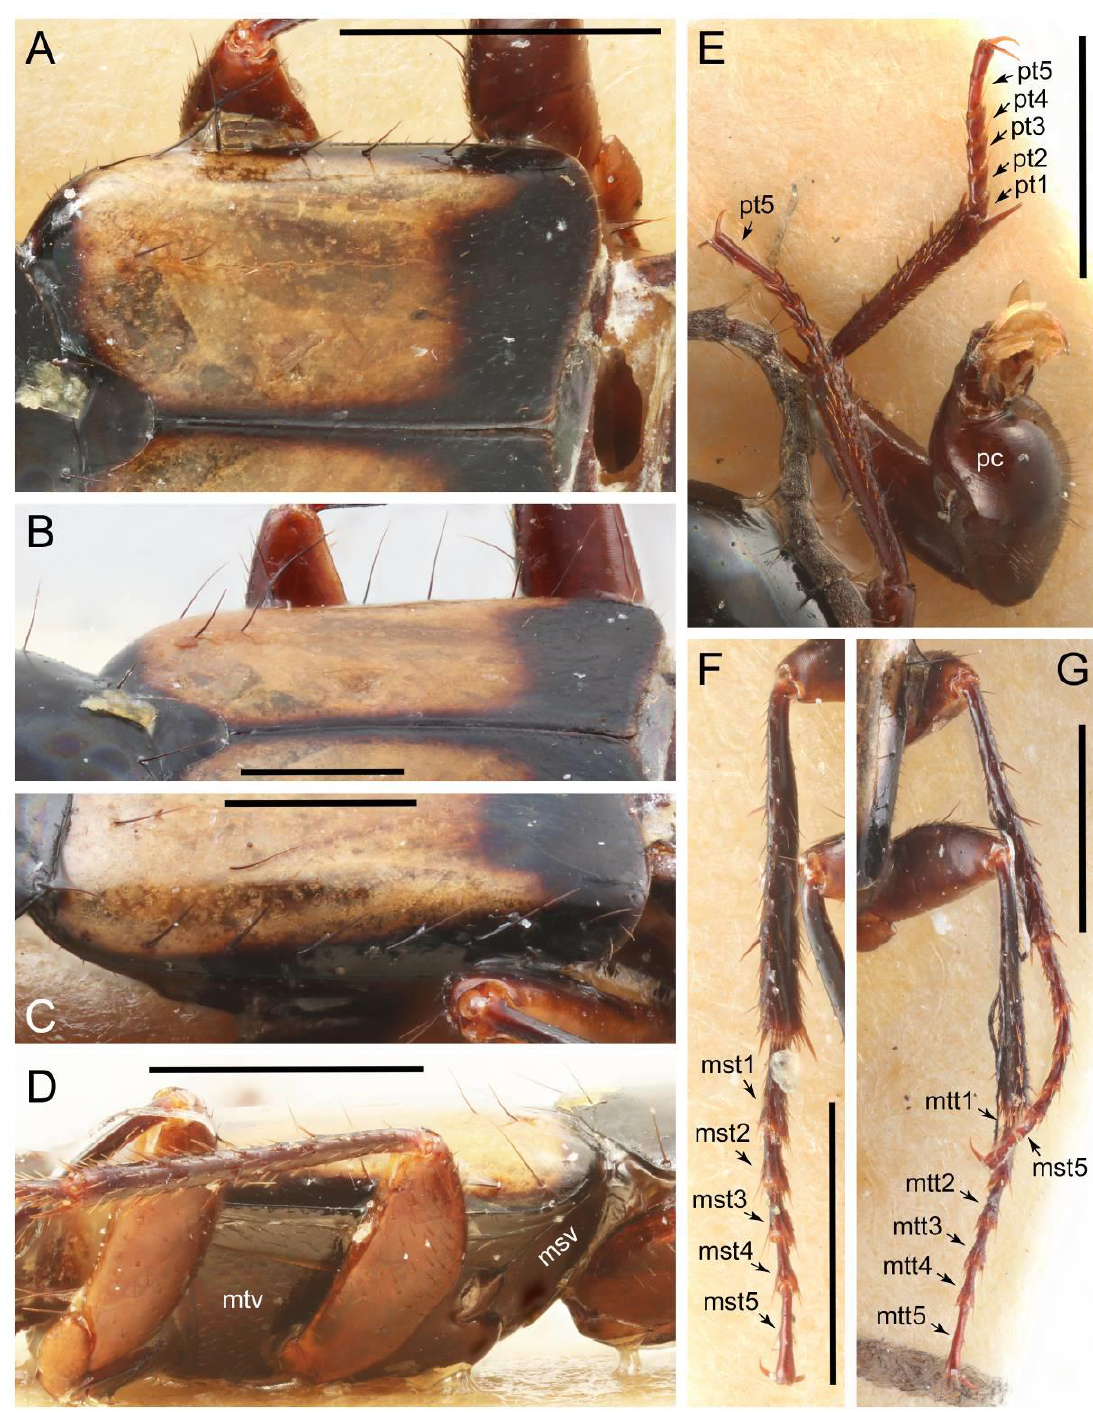
Figure 38. Photographs of Vatesini ( Tachinoporus basalis , male). ( A ) scutellum and right elytron, dorsal view. ( B ) scutellum and right elytron, dorsolateral view. ( C ) left elytron, dorsolateral view. ( D ) meso- and metathorax, ventrolateral view. ( E ) forelegs. ( F ) left midleg, dorsal view. ( G ) right mid- and hindleg, dorsal view. Scale bars: 1.0 mm ( A , D – G ); 0.5 mm ( B , C ). Abbreviations: mst1–5, mesotarsomere 1–5; msv, mesoventrite; mtt1–5, metatarsomere 1–5; mtv, metaventrite; pt1–5, protarsomere